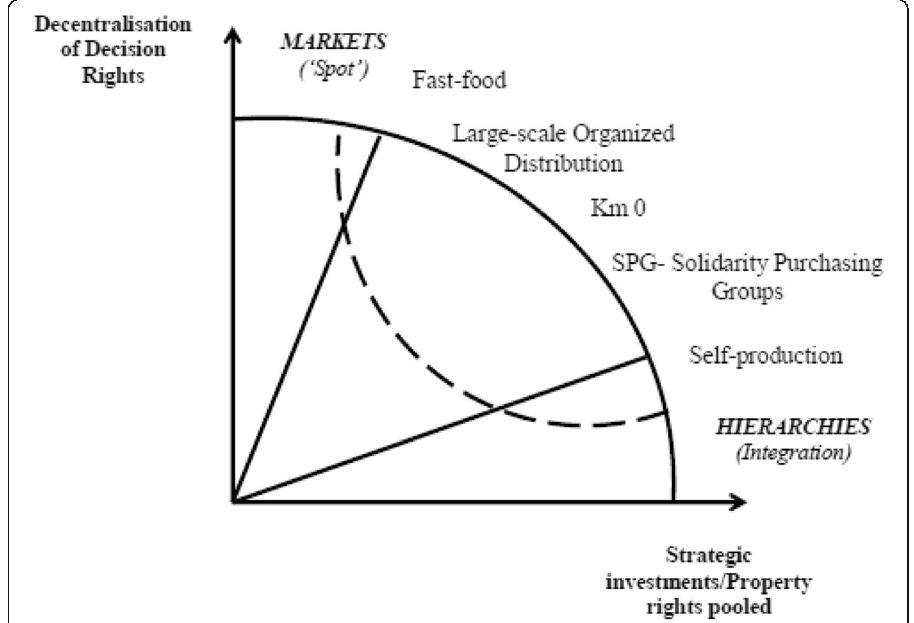
Fig. 3 Consumers ’ investment. Source: Ménard 2013, 2017, 2018 and Martino et al.